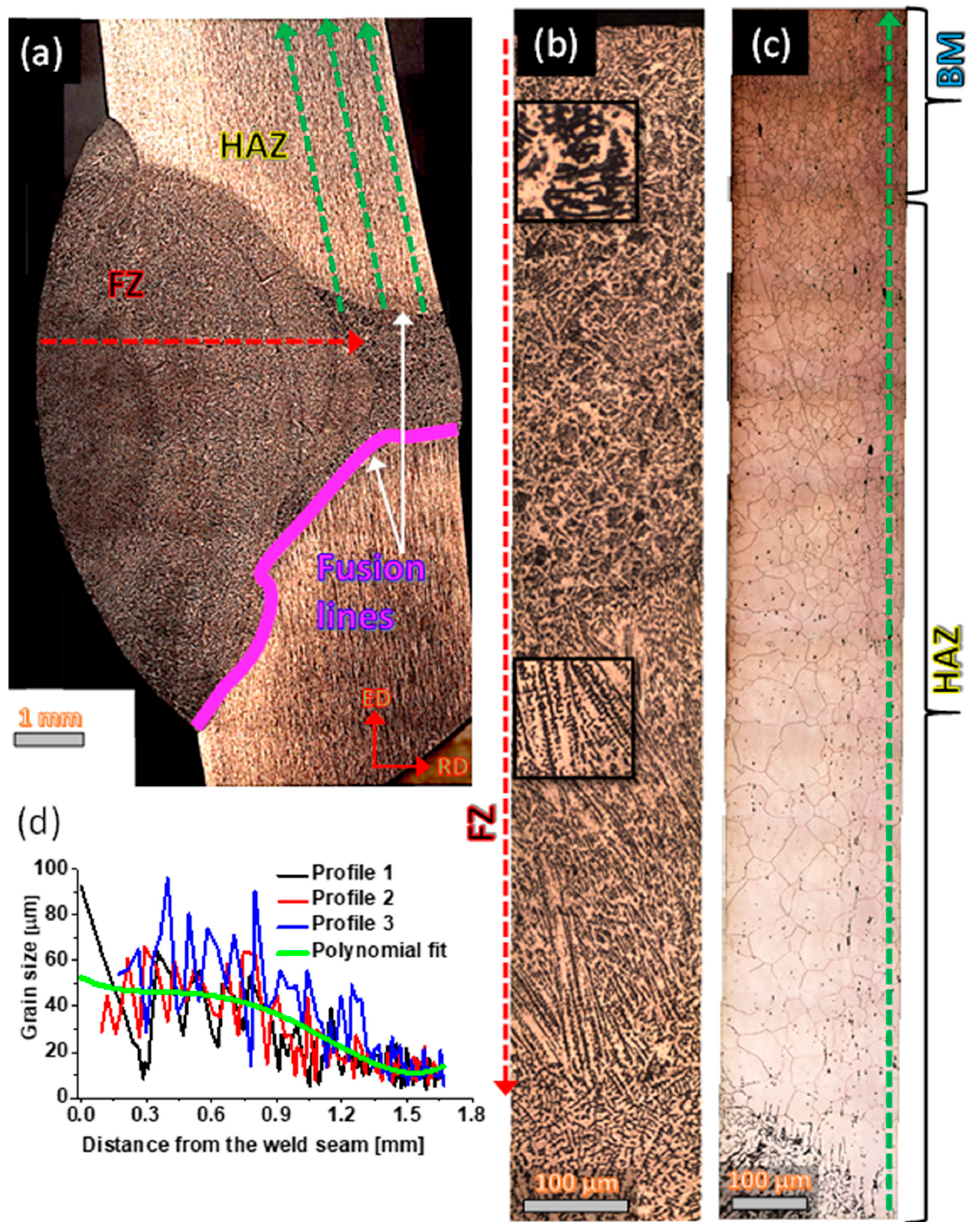
Figure 3. ( a ) Weld seam cross section indicating the FZ, HAZ, and BM, ( b ) microstructural panoramic across the FZ, ( c ) microstructural panoramic between the HAZ and the BM, and ( d ) austenitic grain size evolution across the interphase of the FZ and the HAZ until the BM.